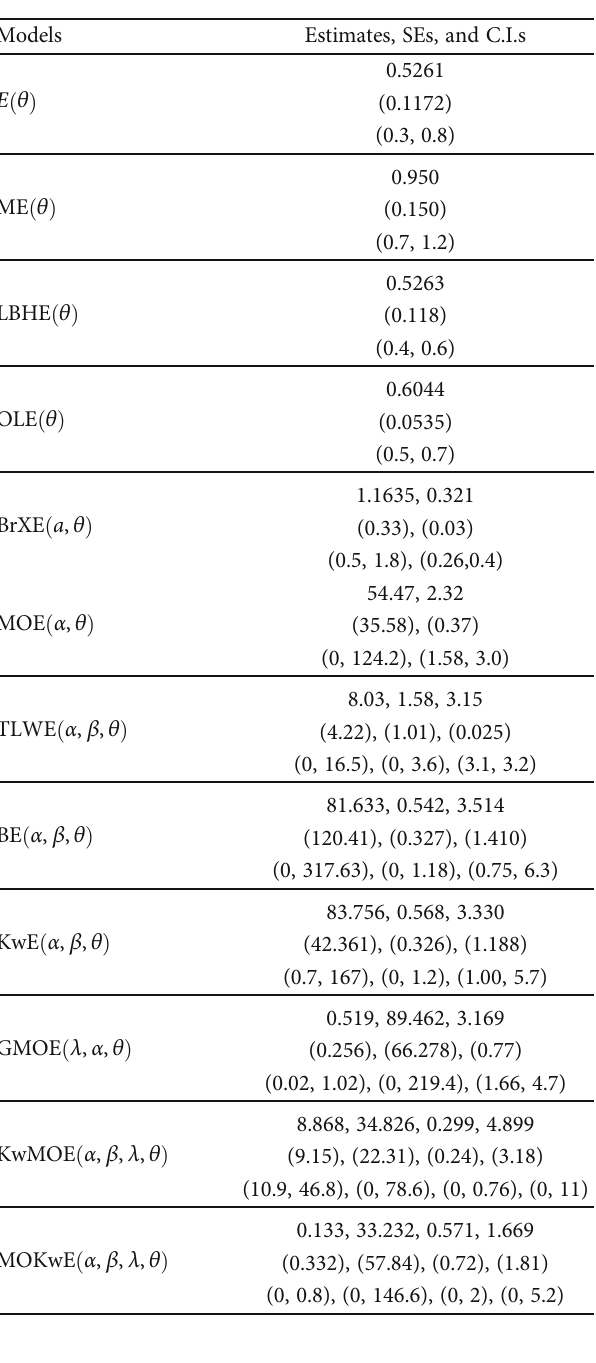
Table 2: MLLEs, SErs, and C.I. (in parentheses) values for the relief time data. Models Estimates, SEs, and C.I.s